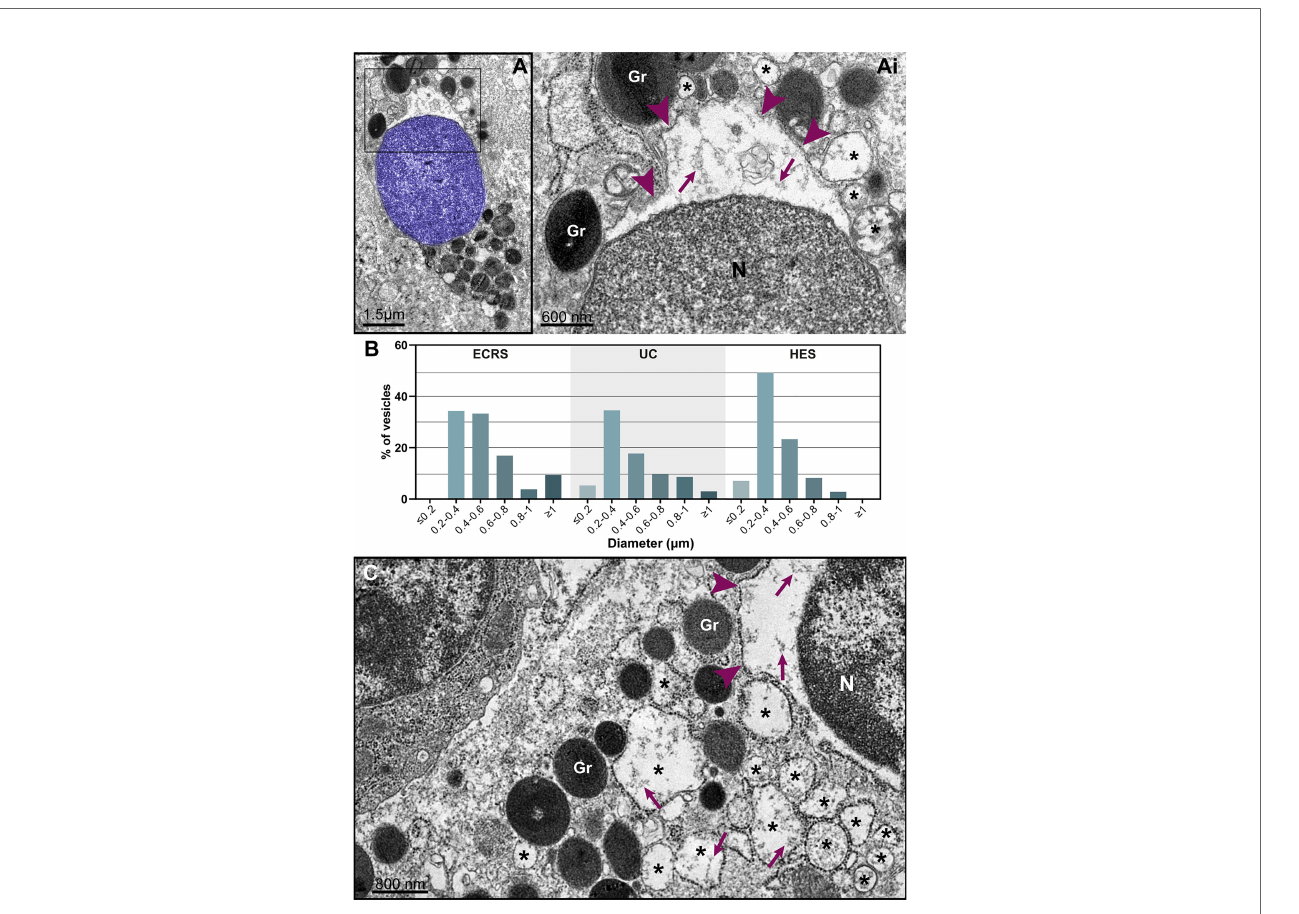
FIGURE 6 | Nuclear envelope alterations associated with ETosis. (A and Ai) Typical ETotic eosinophils with decondensed, delobulated, and round nucleus (blue) showing separation of the inner and outer nuclear membranes with enlargement of the perinuclear compartment (boxed area seen in higher magni fi cation in Ai). Arrowheads indicate the external nuclear membrane. Note that the same content (strings, arrows) within the perinuclear space is seen in the lumen of vesicles (*) derived from the nuclear envelope. (B) Size range (diameter) of nuclear envelope-originated vesicles in eosinophils undergoing ETosis during EADs. A total of 296 vesicles from ETotic eosinophils were analyzed [92 for eosinophilic chronic rhinosinusitis (ECRS), 88 for ulcerative colitis (UC), and 86 for hypereosinophilic syndrome (HES)]. In (C) , a cytolytic non-ETotic eosinophil (nucleus with euchromatin/heterochromatin distinction) showing the same structural changes of the nuclear envelope as seen in (A) . Representative images are from biopsy samples (nasal sinuses) from ECRS patients (n = 2) prepared for